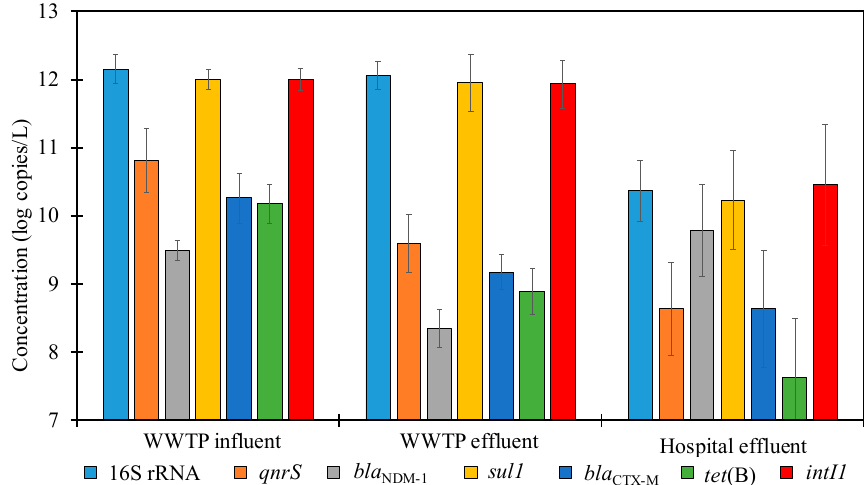
Figure 3. The abundance of 16S rRNA, ARGs, and intI1 in WWTPs and hospitals.